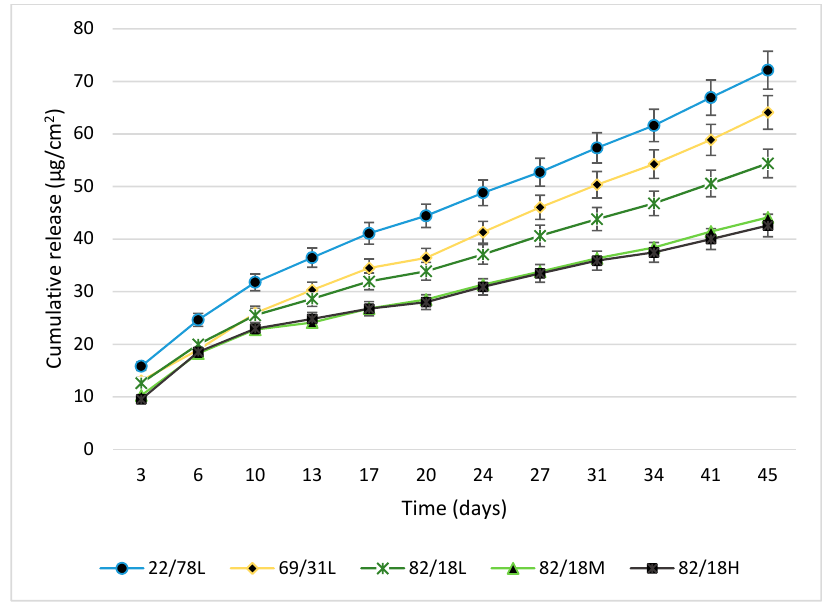
Figure 2. Release of zinc pyrithione from P(CL-VL) paints.